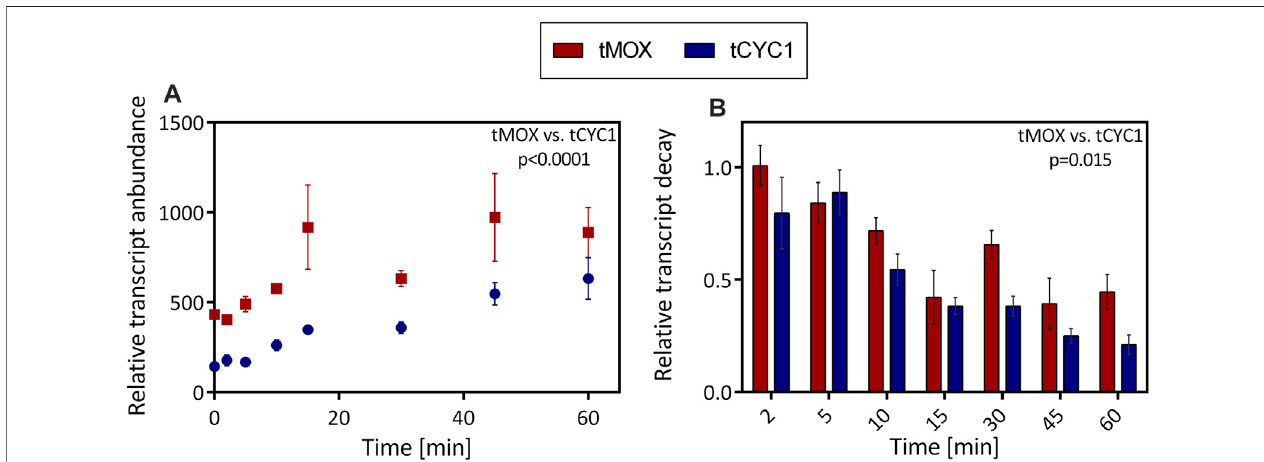
FIGURE 4 | Comparison of mRNA abundance and decay in O. polymorpha strains expressing a genetic construct with the tMOX or tCYC1 terminator. In exponentially growing cultures, transcription was inhibited through the addition of the antibiotic 1,10-phenanthroline. After inhibition, RNA was extracted at regular time points within 1 h. (A) Level of target mRNA (tMOX and tCYC1) relative to the mRNA of the reference gene TAF10. (B) Relative transcript decay: Abundance of the target mRNAs relative to the reference gene TAF10 and the initial difference between target and reference mRNA at t = 0. Error bars represent three technical replicates. The means transcript abundance (A) and the relative transcript decay (B) were compared using a paired, two-tailed Student ’ s t -test. Statistical signi fi cance is indicated as the p value on the graph (Caluclations in Supplementary Information